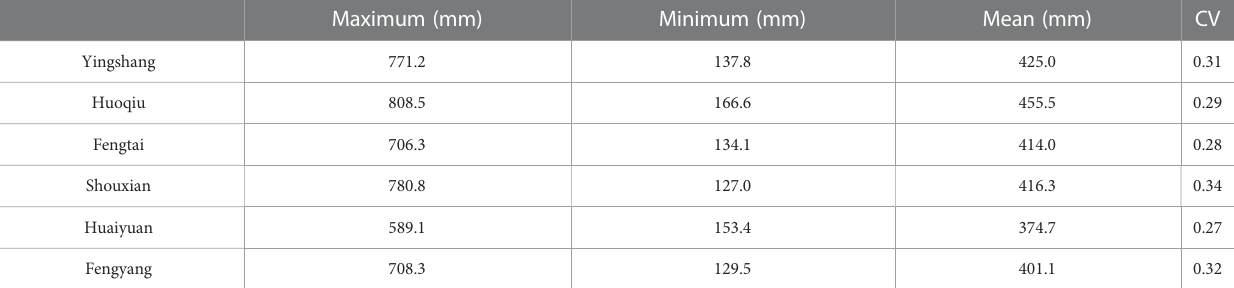
TABLE 4 Precipitation characteristics during wheat growing season from 1999 to 2020 at six meteorological stations.